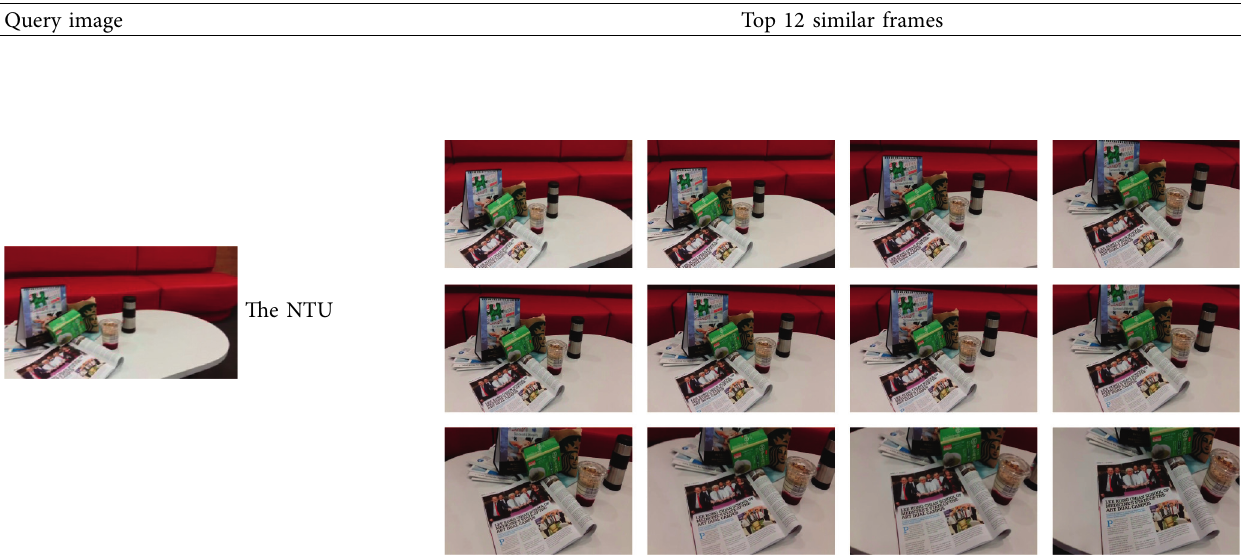
Table 3: Example of the top 12 similar frames for the query image on the